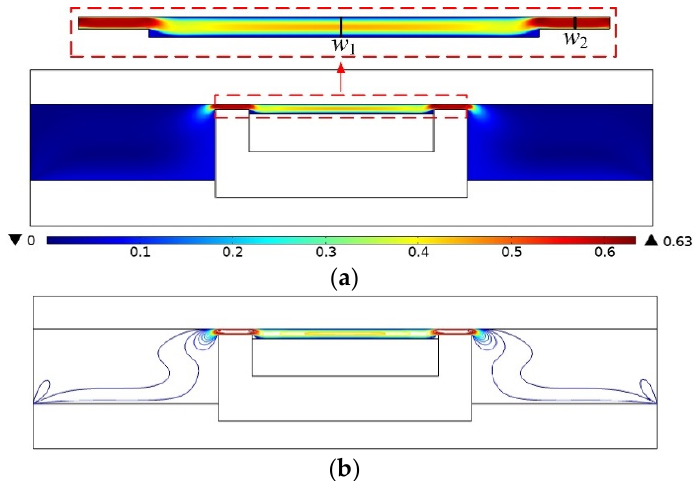
Figure 9. Velocity distribution of the MR damper. ( a ) Contour of flow velocity, ( b ) distribution of flow velocity.